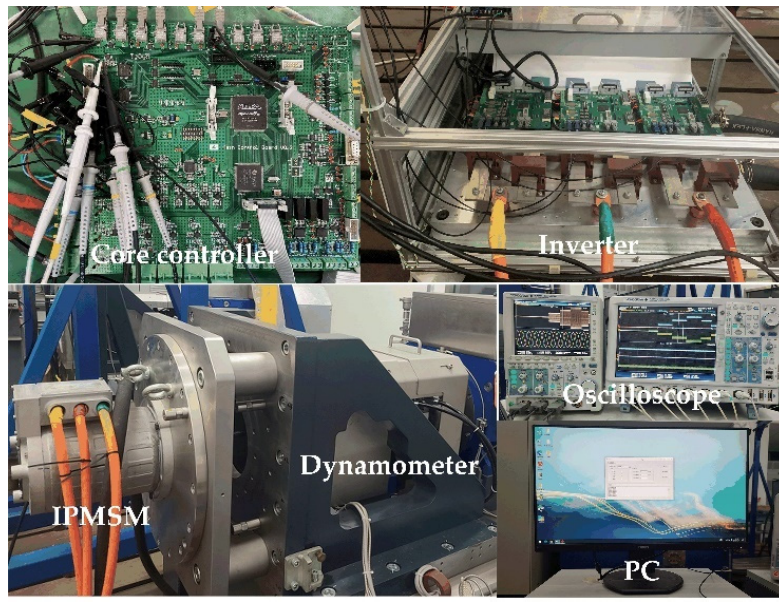
Figure 11. Diagram of experimental system.